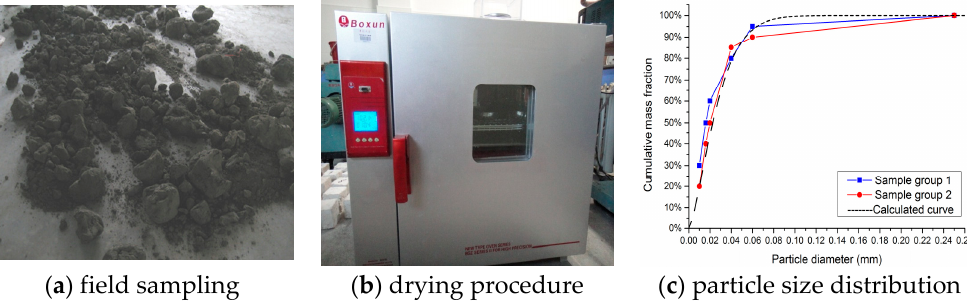
Figure 2. Backfilling materials sampling and particle size test.